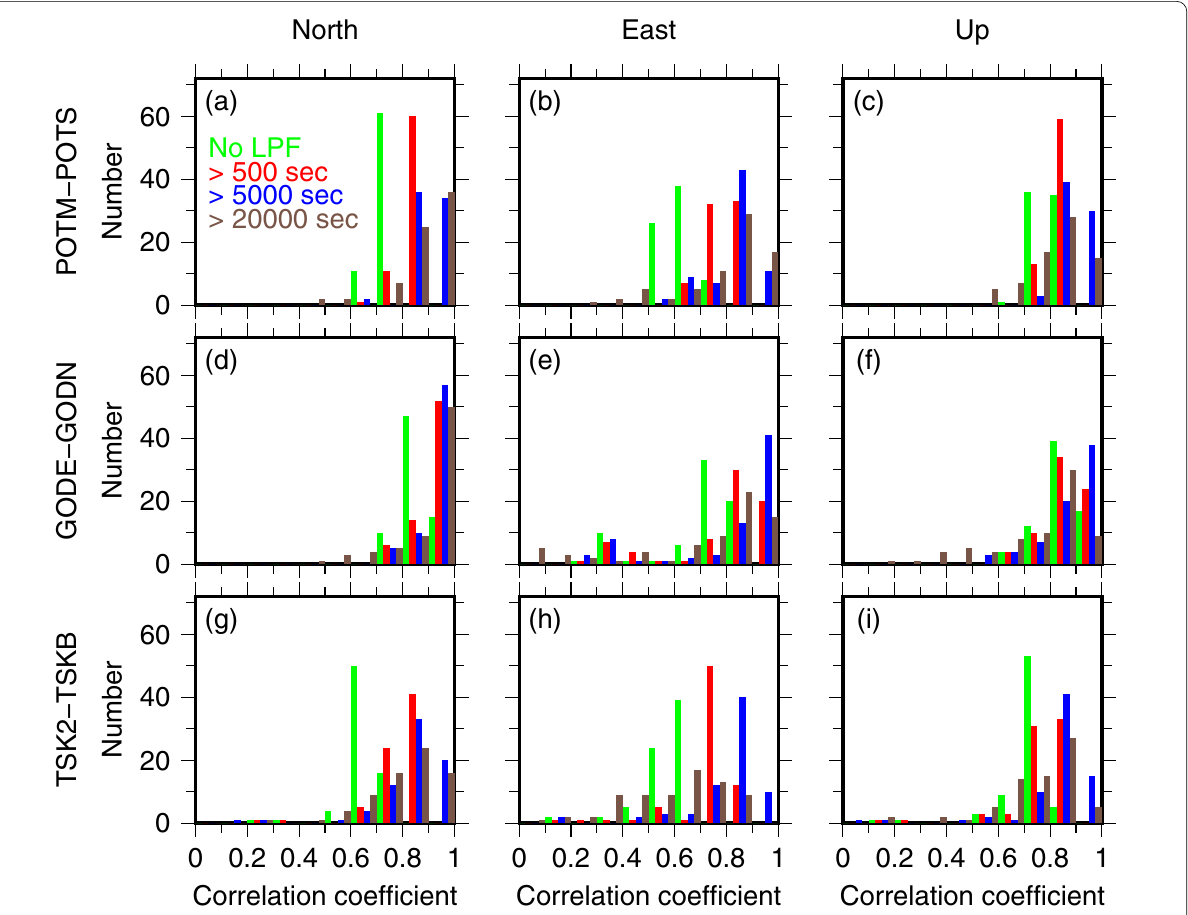
Fig. 4 Histograms of correlation coefficients of 72 pairs of neighboring blocks. a – c Correlation coefficients of coordinates without (green) and with (others) low-pass filtering (LPF) for north ( a ), east ( b ), and up ( c ) components of a baseline POTM-POTS. A cut-off period of LPF is 500 (red), 5000 (blue), and 20,000 (brown) seconds. d – f Same as a – c but for a baseline GODE-GODN. g – i Same as a – c but for a baseline